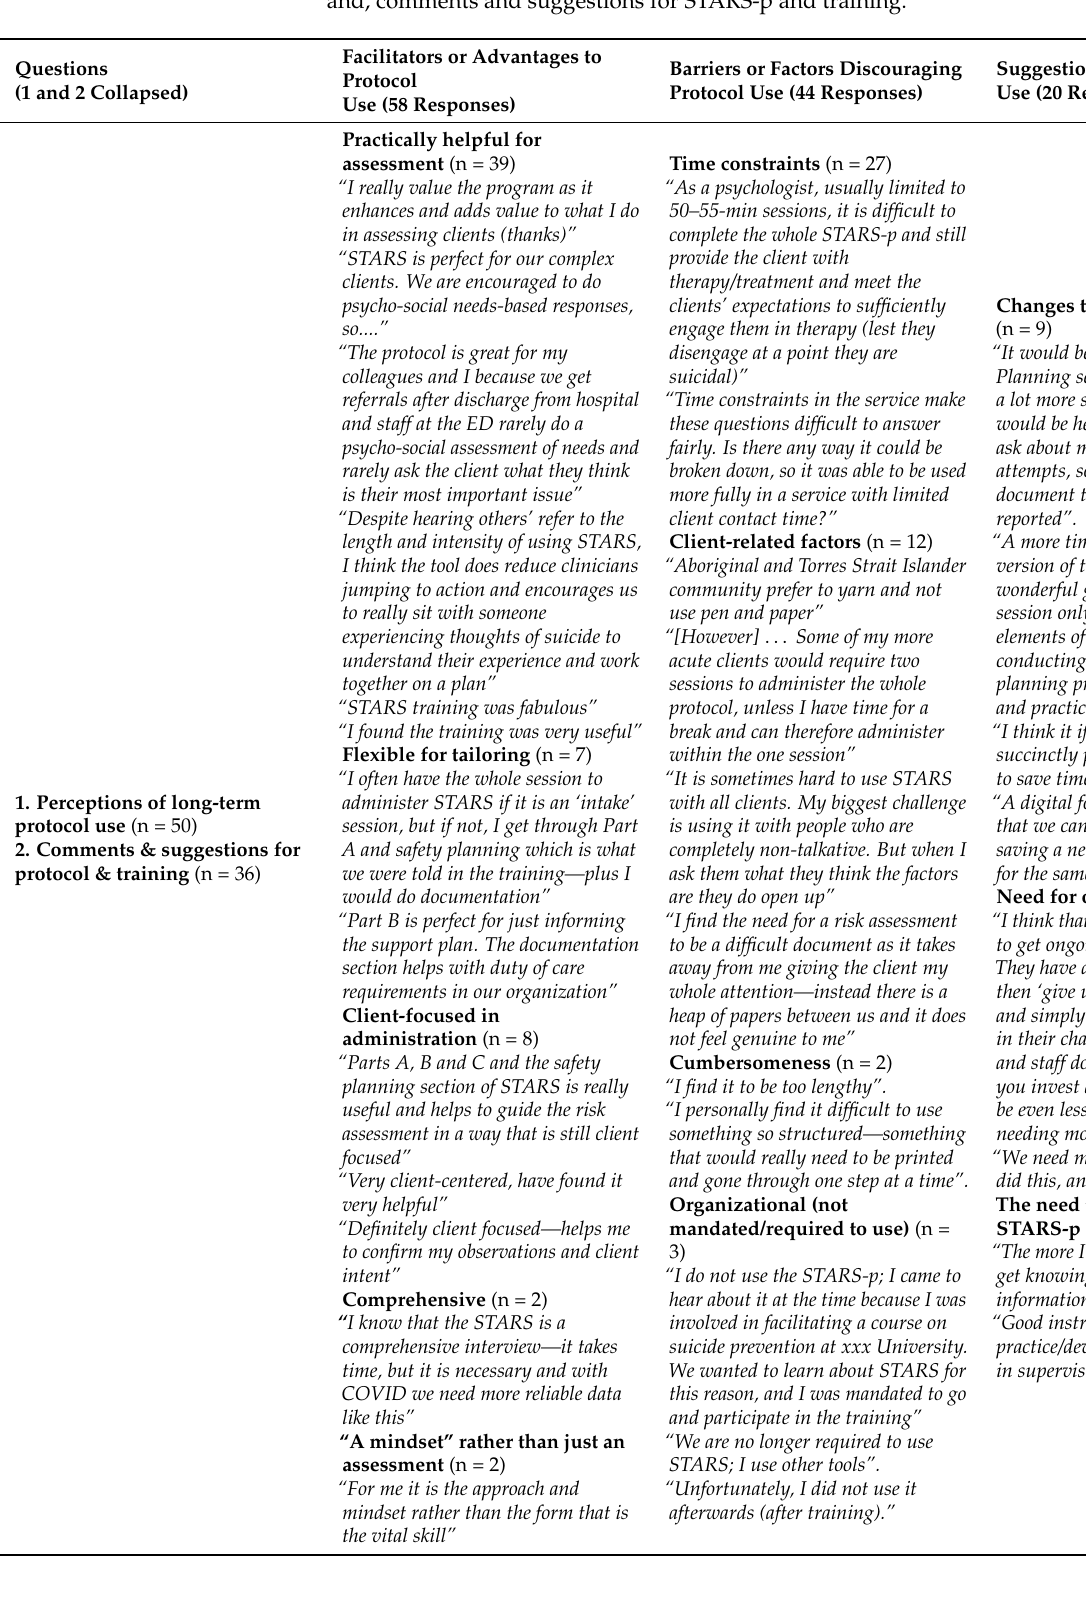
Table 5. Qualitative content-analysis of open-ended questions: Perceptions of STARS-p in practice and, comments and suggestions for STARS-p and